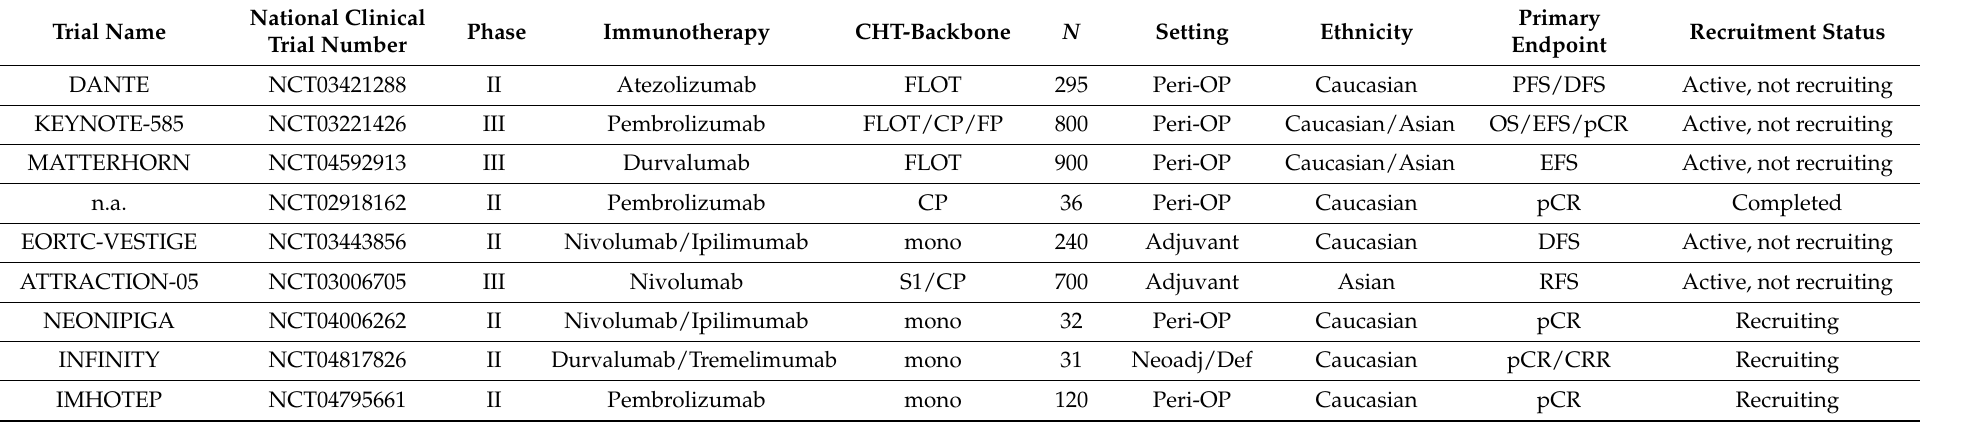
Table 1. Clinical trials investigating immunotherapeutic agents in localized gastroesophageal adenocarcinoma.